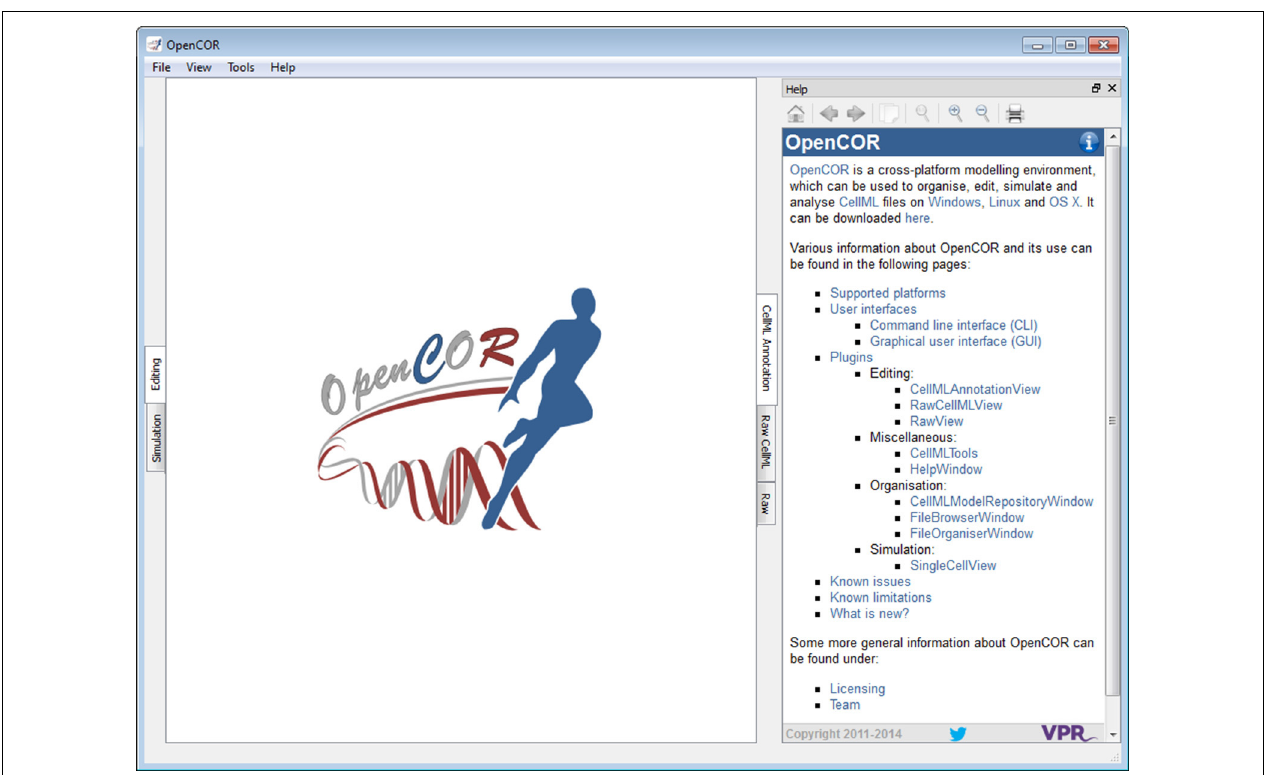
FIGURE 3 | Help window. The Help window shows the contents of the online user documentation